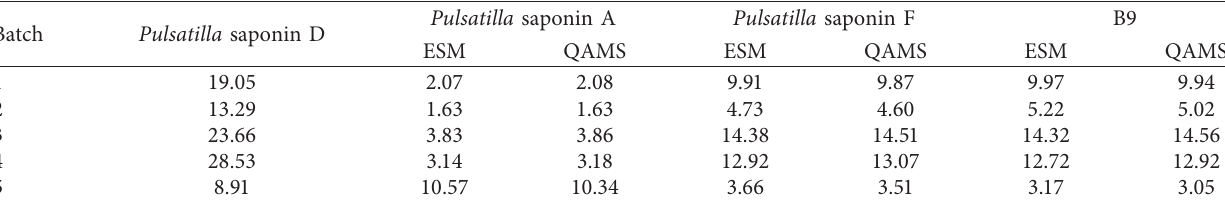
Table 9: The content (%) of four saponins in different batches of extracts of Pulsatilla chinensis determined by two different methods.